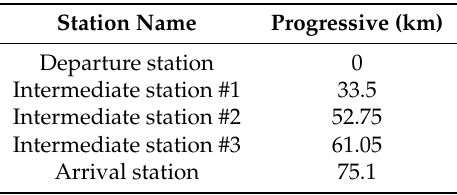
Table 3. Position of the